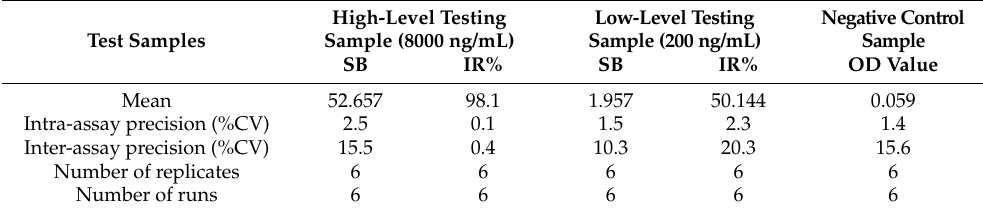
Table 1. Intra- and inter-assay precision